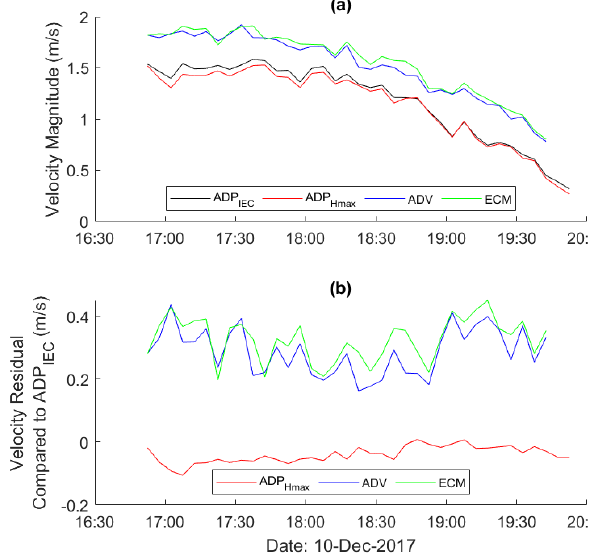
Fig. 3. Sample period showing (a) velocity magnitude (m/s) from ADP, ADV and ECM, (b) residual velocity when subtracted from ADP IEC data